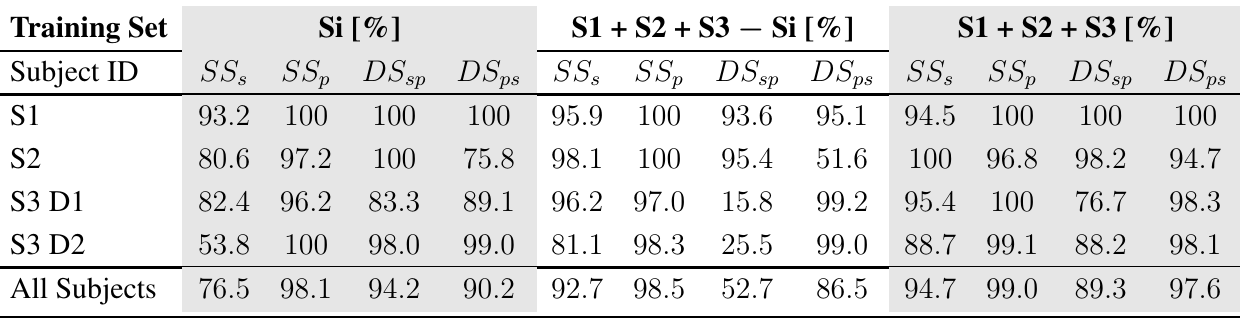
Table 7. Success rates for detection of gait phases using hidden Markov